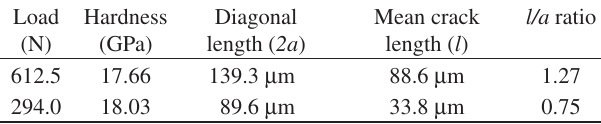
Table 2. Example of experimental results obtained in the hardness testing of WC-6Co 17 .